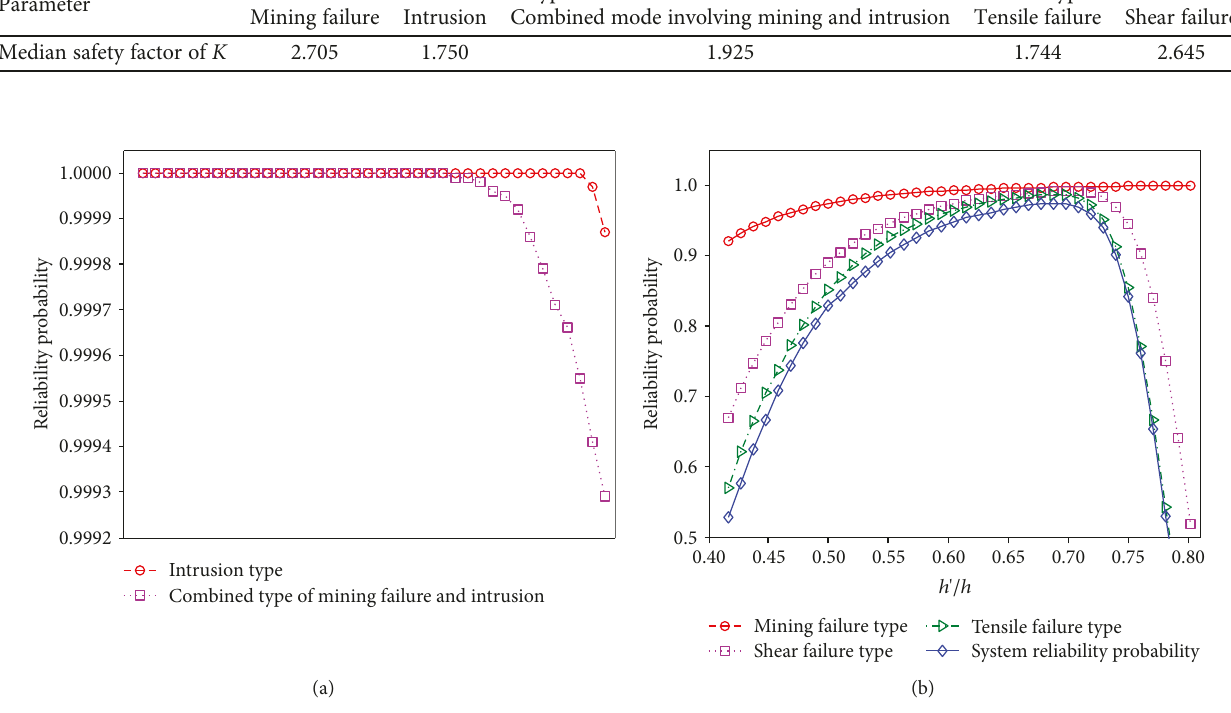
Table 2: Calculation results of the median safety factor of stability of the water-resistant fl oor.